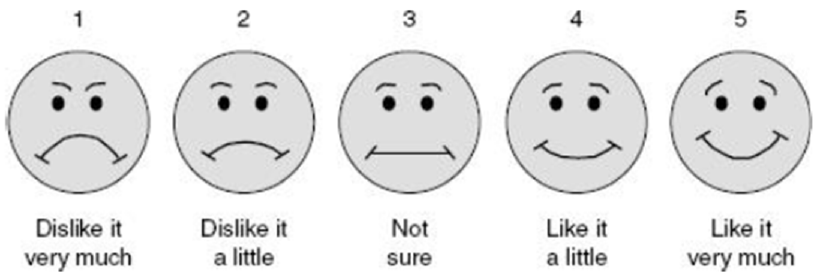
Figure 2 . 5-point Hedonic scale utilized in the child (5–12) surveys . Figure 2. 5-point Hedonic scale utilized in the child (5–12)